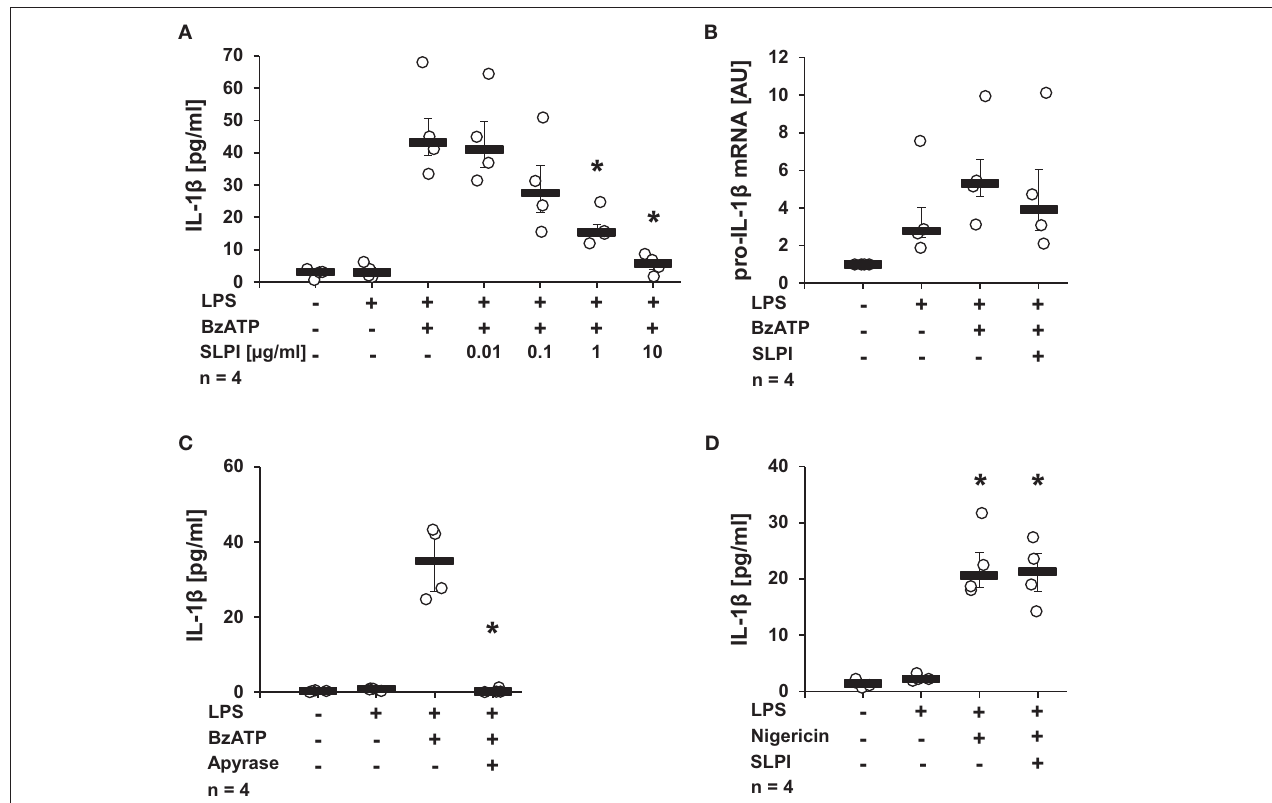
FIGURE 1 | SLPI inhibits BzATP-mediated IL-1 β release by U937 cells. Human monocytic U937 cells were primed with LPS (1 µ g/ml, for 5h) and further stimulated with 2 ′ (3 ′ )-O-(4-benzoylbenzoyl)adenosine 5 ′ -triphosphate triethylammonium salt (BzATP; 100mM) or nigericin (50 µ M) for 30min. The concentration of IL-1 β in cell culture supernatants was measured by ELISA. The mRNA expression of pro-IL-1 β was assessed by real-time PCR. (A) SLPI dose-dependently and effectively inhibited the BzATP-mediated IL-1 β release. (B) The LPS-induced mRNA levels of pro-IL-1 β were not changed upon stimulation with SLPI. AU, arbitrary units (C) The treatment with apyrase (0.5 U/ml) fully abolished the BzATP-mediated IL-1 β release. (D) The nigericin-mediated IL-1 β secretion was not affected in the presence of SLPI. * p ≤ 0.05 significantly different compared to cells stimulated with LPS and BzATP (A,C) or LPS alone (D) . Experimental groups were compared by Kruskal-Wallis test followed by Mann-Whitney rank sum